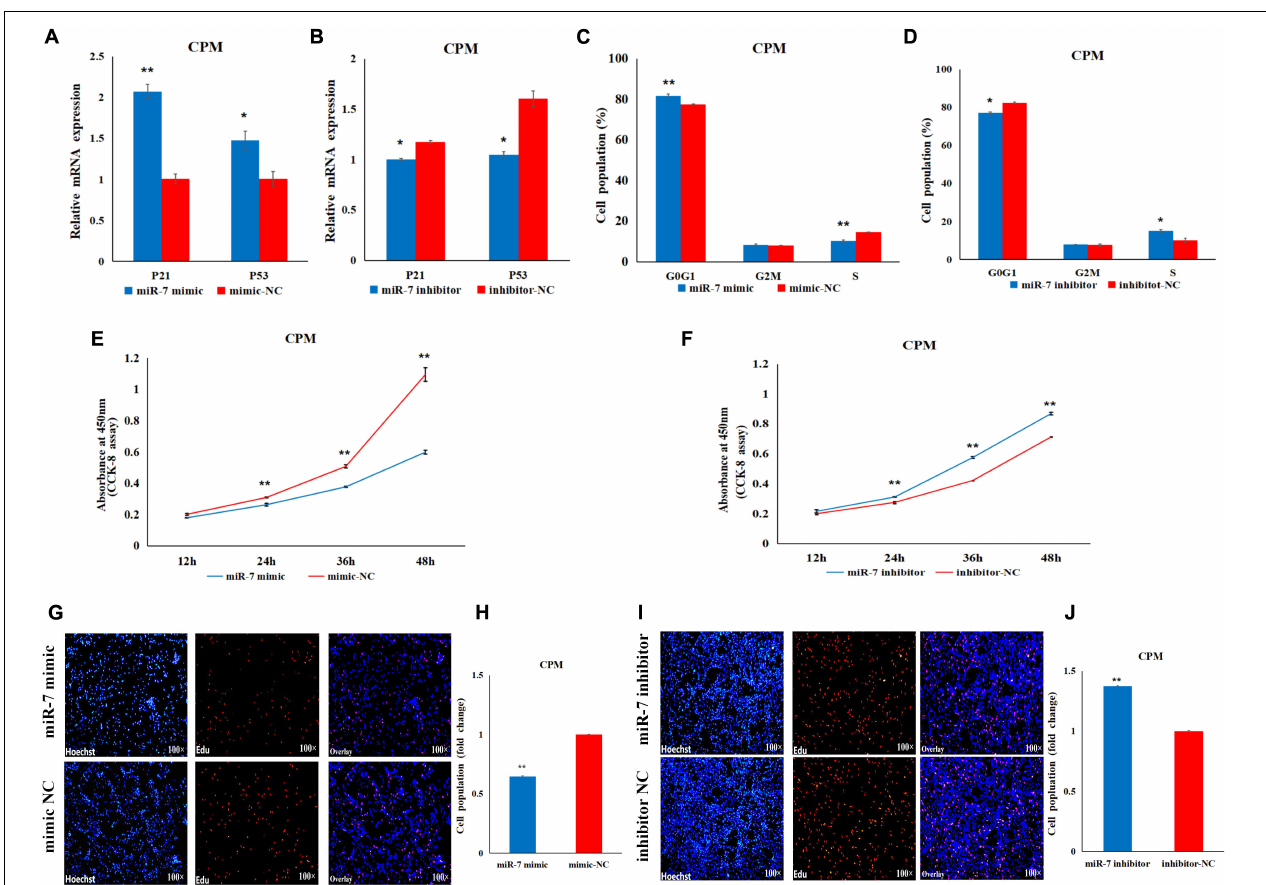
FIGURE 2 | MiR-7 inhibits the proliferation of chicken primary myoblasts (CPMs). (A,B) Effects of the overexpression and inhibition of miR-7 on the mRNA expression of the P21 and P53 genes 48 h after the transfection. (C,D) The statistical results of the cell cycle analysis 48 h after the overexpression and inhibition of miR-7 in CPMs. (E,F) Cell growth was measured in CPMs using CCK-8 assay after overexpression and inhibition of miR-7. (G–J) 5-ethynyl-2 (cid:48) -deoxyuridine (EdU) staining of transfected CPMs and the calculation of the proliferation rate. Photomicrographs were taken using a 100 × magnification. The results are shown as the mean ± SEM of three independent experiments, * p < 0.05, ** p <